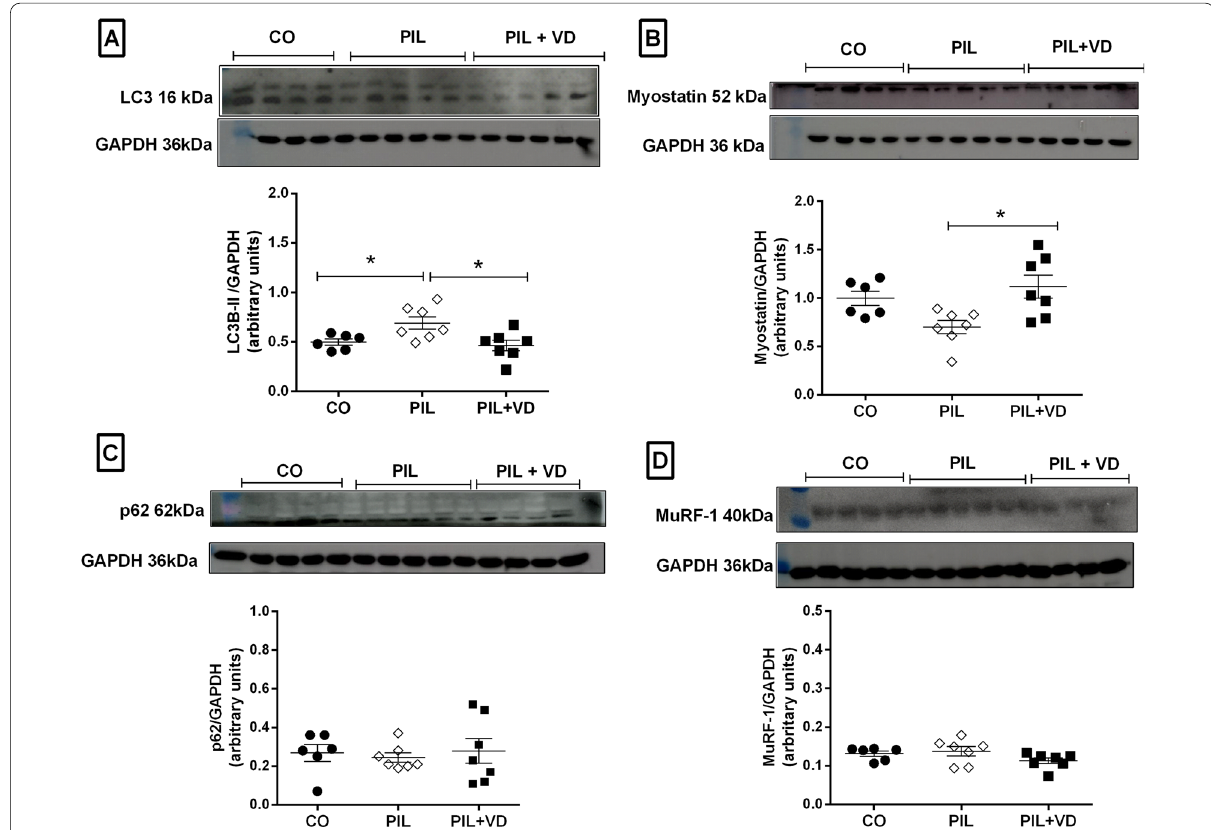
Fig. 4 Protein expression of degradation markers in gastrocnemius muscle. Expression of ( a ) LC3, ( b ) myostatin, ( c ) p62 and ( d ) MuRF-1 in CO, PIL and PIL VD groups. Data in ( a ) and ( b ) represent mean +